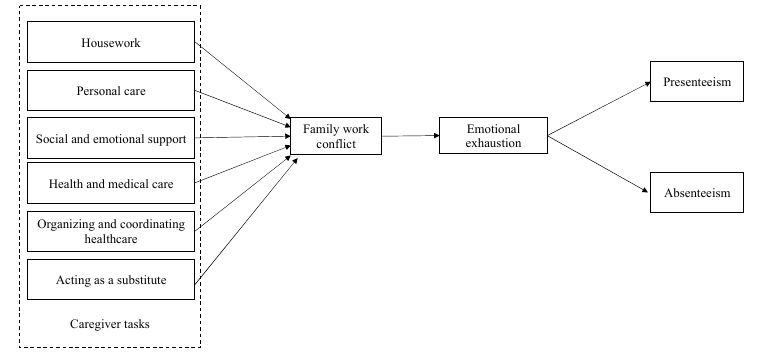
Figure 1. The theoretical model.